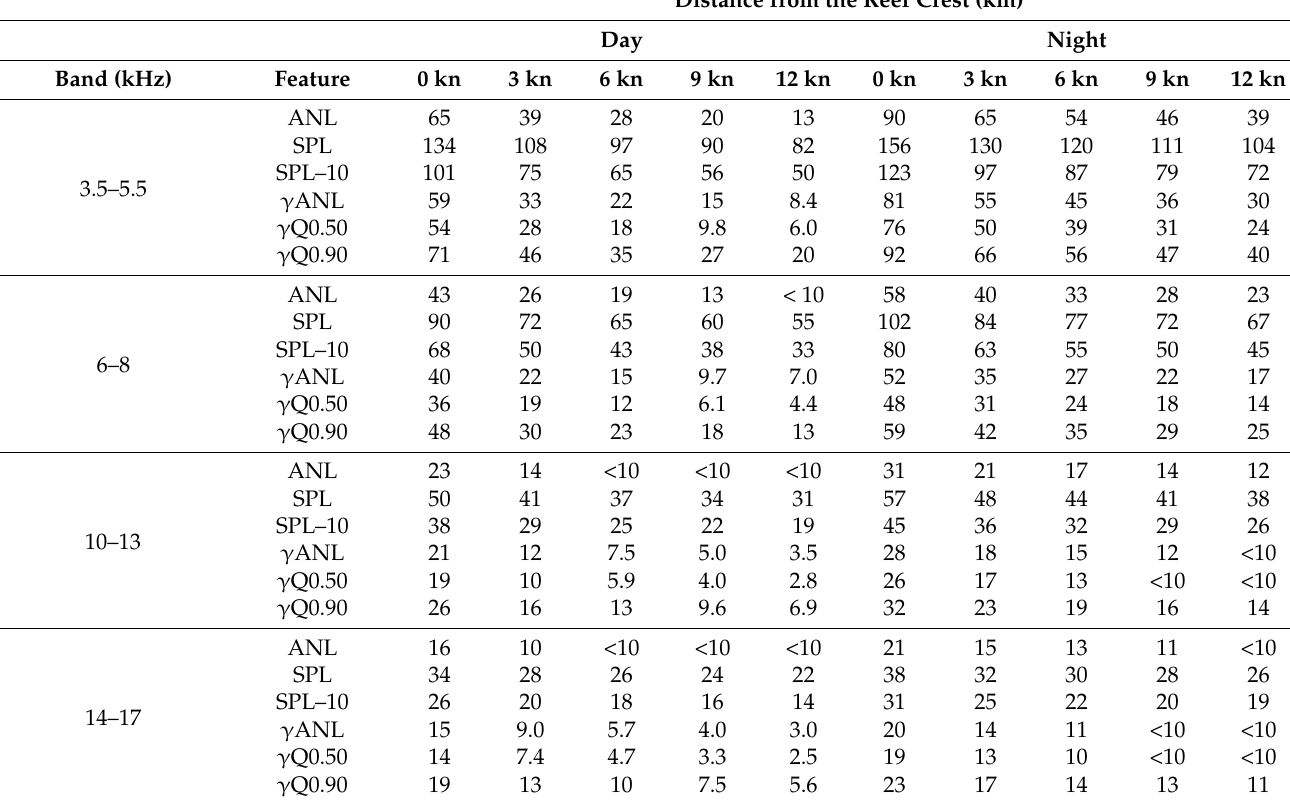
Table 2. Distance of detection (km) of the investigated Broadband Transient Sounds (BTS) frequency bands at day and night under different wind regimes as reported by Wenz (1962). ANL = ambient noise level, SPL = sound pressure level, both measured in dB re 1 µ Pa, kn = knot. γ ANL, γ Q 0.50 = 50th percentile and γ Q 0.90 = 90th percentile, measured as dB re 1 µ Pa 2 Hz − 1 from the power